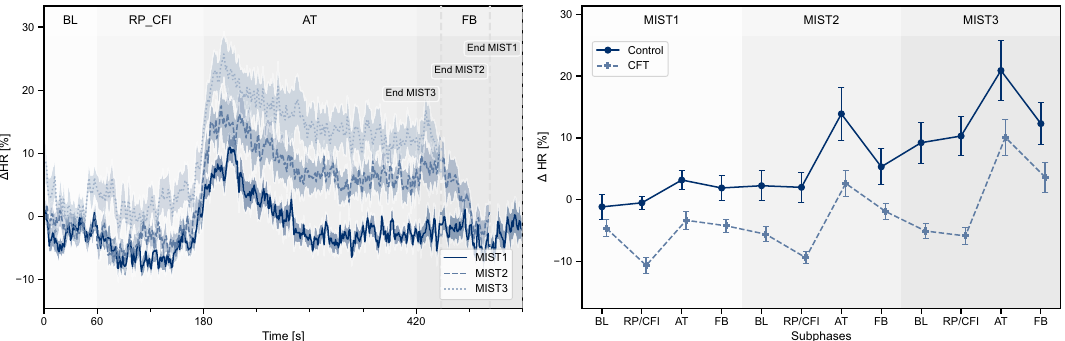
Figure 2. Left: Course of heart rate during the different MIST phases for both conditions combined, each consisting of Baseline (BL), Resting Period / Cold Face Intervention (RP/CFI), Arithmetic Tasks (AT), and Feedback (FB) subphases. Right: Average heart rate per MIST subphase during the conduction of the MIST. Values are depicted as mean and standard